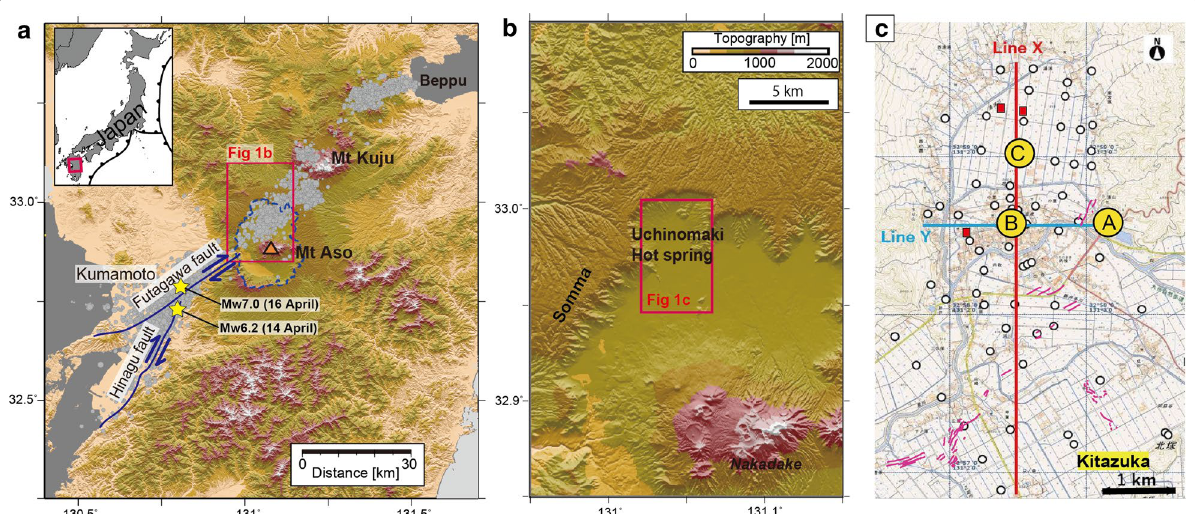
Fig. 1 Maps of central Kyushu Island, Japan, and the Uchinomaki hot spring area. a Locations of the faults (blue lines) and hypocenters of the foreshock and mainshock (yellow stars) and aftershocks (gray dots) of the 2016 Kumamoto earthquake are shown (modified from Tsuji et al. 2017). The dashed line outlines Aso caldera. b Enlarged map around the Uchinomaki hot spring area. c Positions of microtremor arrays (white dots). Purple lines represent open fissures revealed by field observations and interpretations of satellite data (Tsuji et al. 2017). We used the 10-m mesh digital elevation model (DEM) in a , b , and regional map in c published by the Geospatial Information Authority of Japan